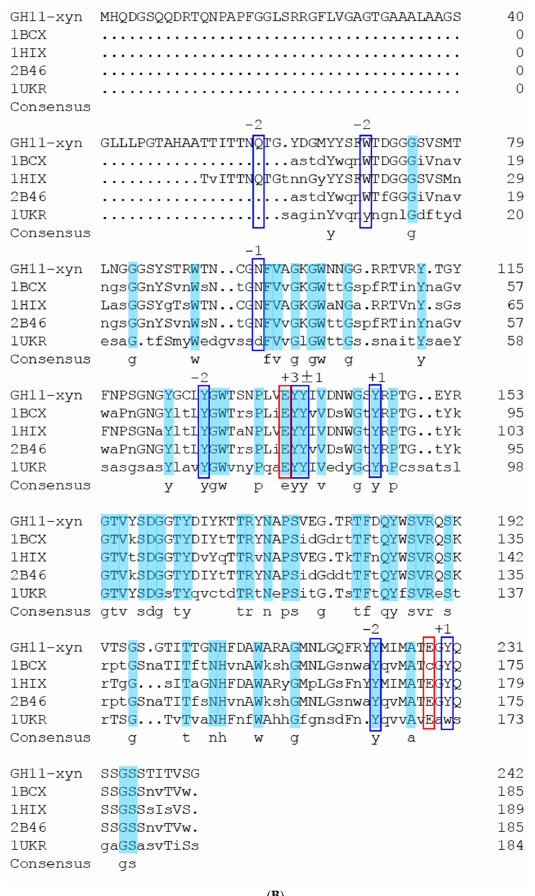
Figure 2. The sequence homology analysis of GH10-xyn ( A ); GH11-xyn ( B ) and others xylanases that has high similarity. Sequences be named according to their Protein Data Bank (PDB) code, which have identified the binding sites by crystallographic study. The grey color scheme indicated the conservation of amino acids. The red and blue squares are the catalytic sites and binding sites, respectively.